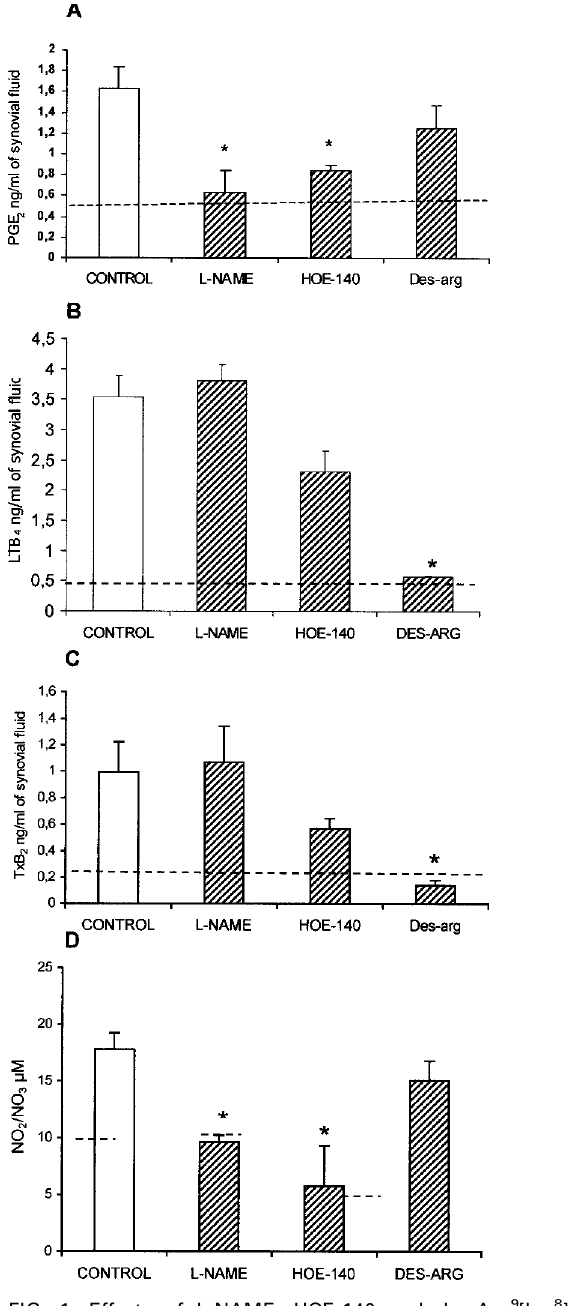
FIG. 1. Effects of L-NAME, HOE-140 and des-Arg 9 [leu 8 ]- bradykinin treatments on local eicosanoid and NO produc- tion 4h after intra-articular injection of BjV. (A) PGE 2 levels, (B) LTB 4 levels (C) TxB 2 levels and (D) NO 2 ·/NO 3 · levels following treatments with L-NAME ( n = 5), HOE-140 ( n = 4) and des-Arg 9 [Leu 8 ]-bradykinin ( n = 5). Open column, the level of the eicosanoid in control animals ( n = 6). Dotted line, the values of each eicosanoid in the BSA-injected joint. Each column expresses data as the mean (±s.e.m.). * p < 0.05 by comparison with control